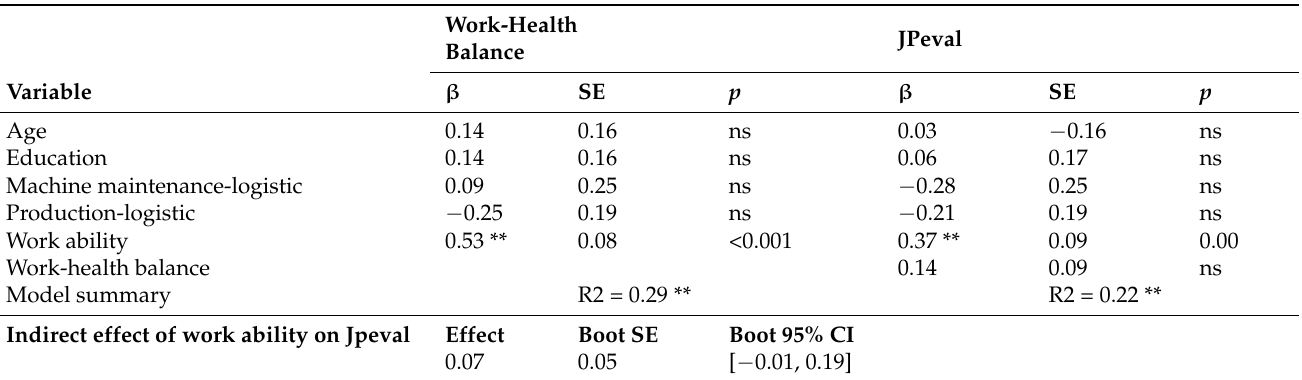
Table 4. Indirect and Direct Associations between Work Ability, Job Performance Evaluated by Supervisor (JPeval) and Work-Health